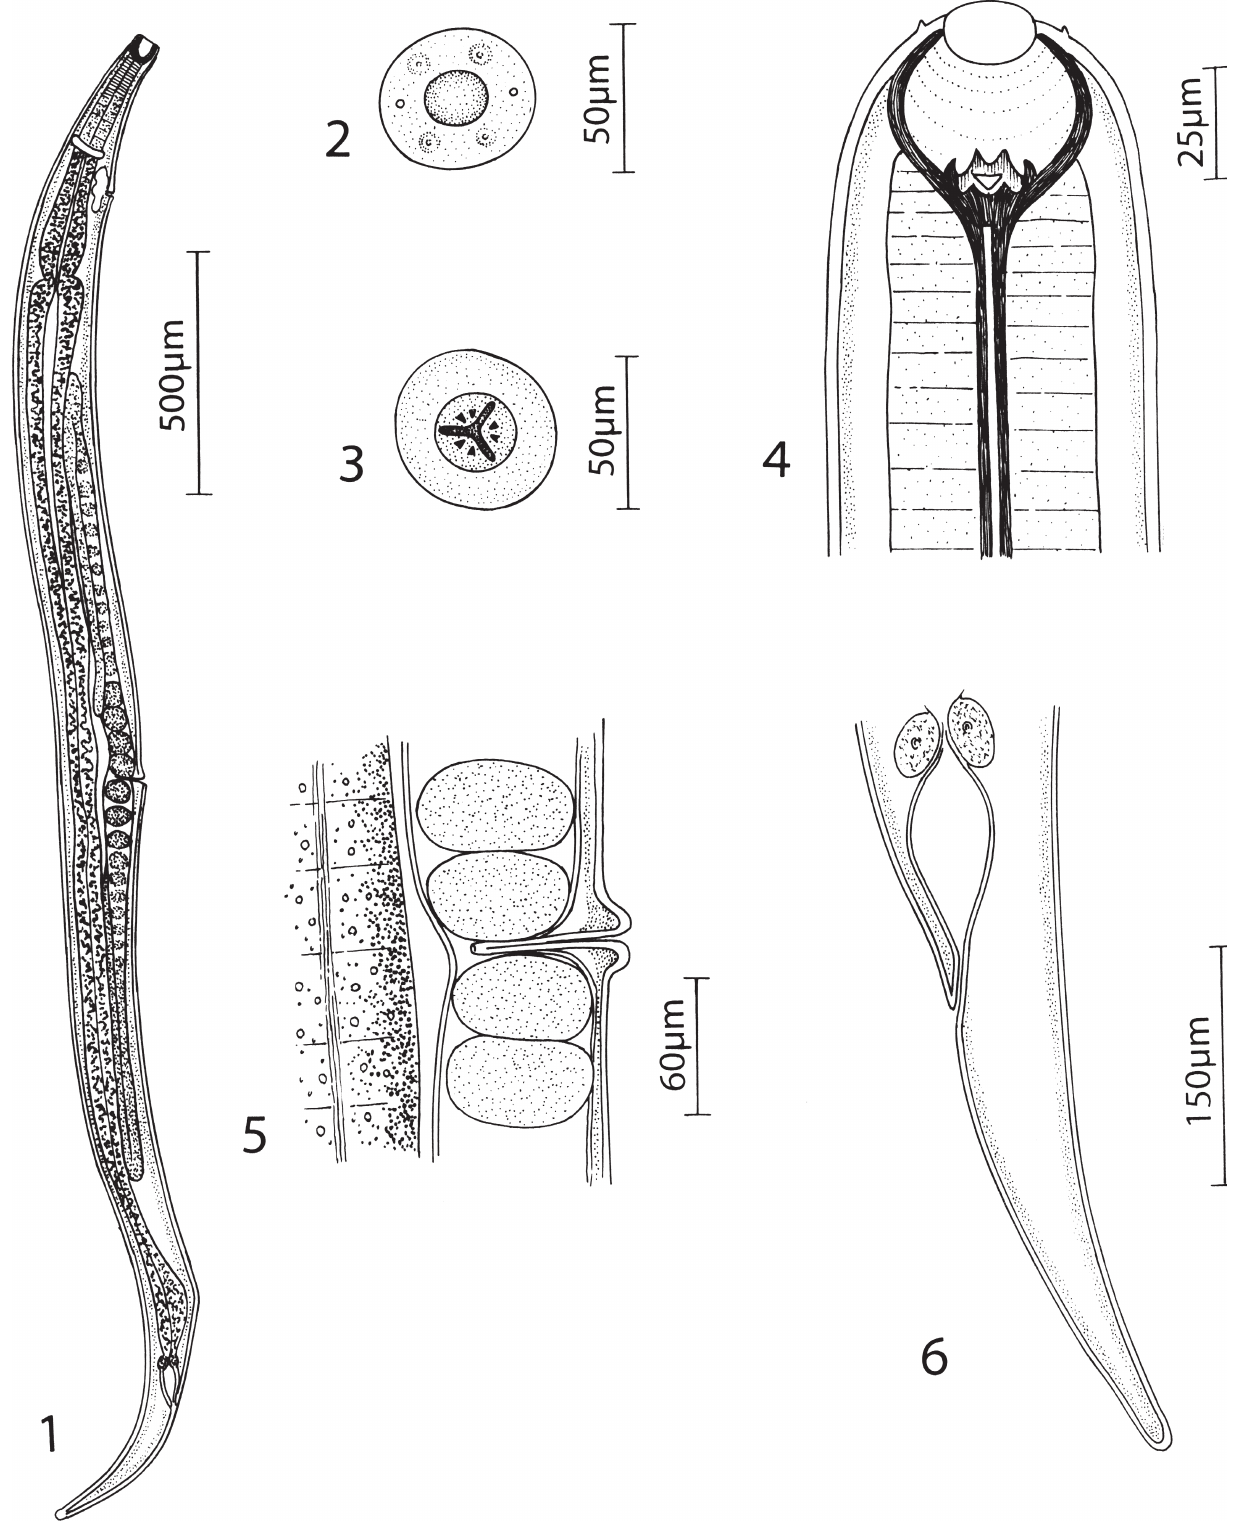
view. Fig. 6: Parthenogenic female, posterior end, lateral